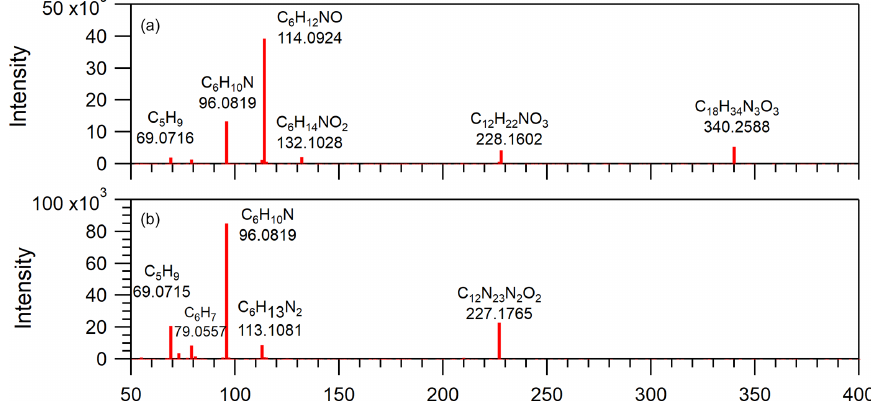
Figure 8. Mass spectra obtained from LC/ESI + –MS/MS measurements of two detected compounds in EXP C9. The [M + H] + ions were detected at (a) m/z 340, using a collision energy of 25eV, and (b) m/z 227, using a collision energy of 20eV.